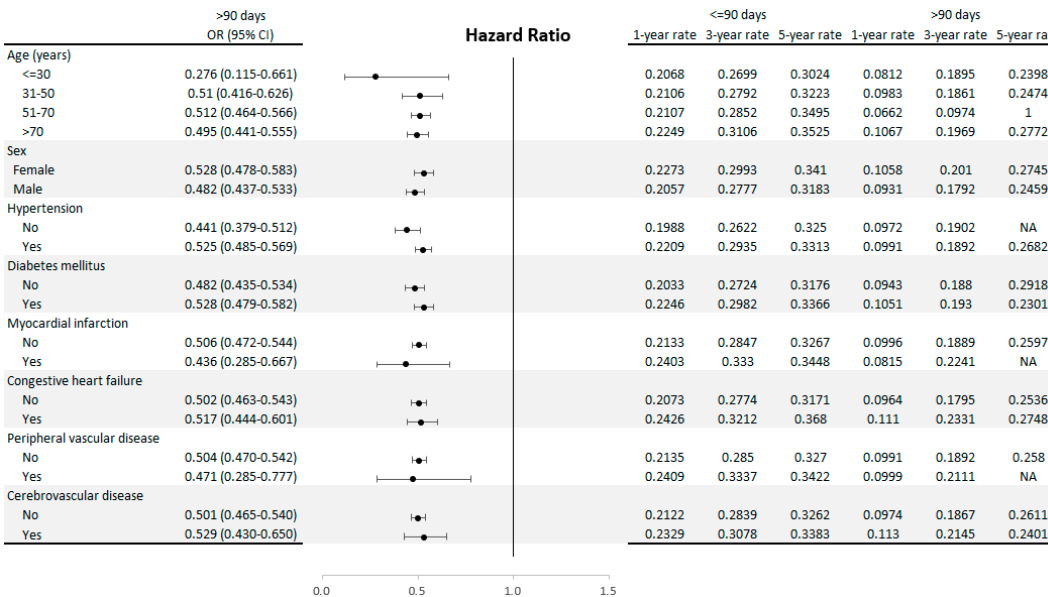
Figure 4. Adjusted Kaplan–Meier plots for ( a ) functional cumulative survival and ( b ) primary patency of fistulas. The model was adjusted for age, gender, history of hypertension, diabetes mellitus, myocardial infarction, congestive heart failure, peripheral vascular disease, cerebrovascular disease, and use of aspirin, clopidogrel, warfarin, and statins.